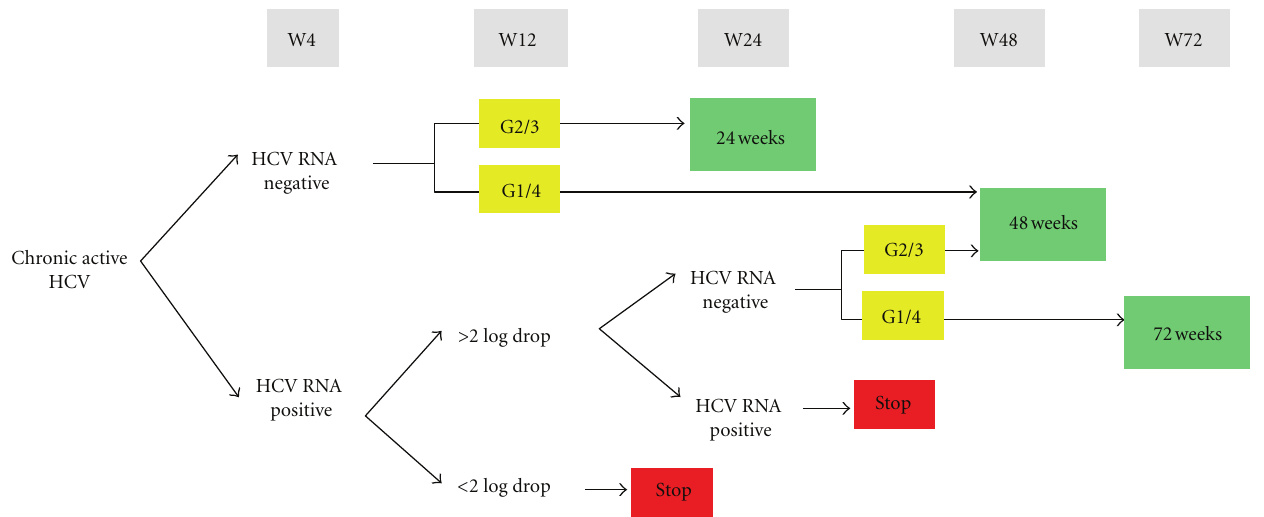
Figure 1: Treatment scheme for HCV coinfection guided by genotype and HCV-RNA load assessment at baseline, wks 4, 12, and 24 [48, 72]. ∗ Patients having baseline HCV-RNA load < 400,000 IU/mL with minimal fibrosis.